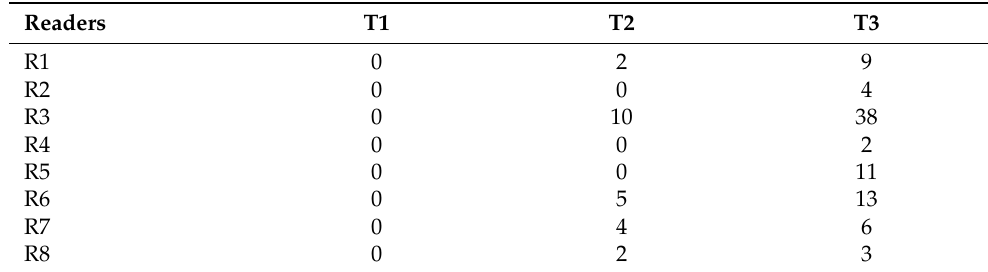
Table 2. Number of words on the STAS-OA1 read by each of the individual participants who were classified as readers at T1, T2 and